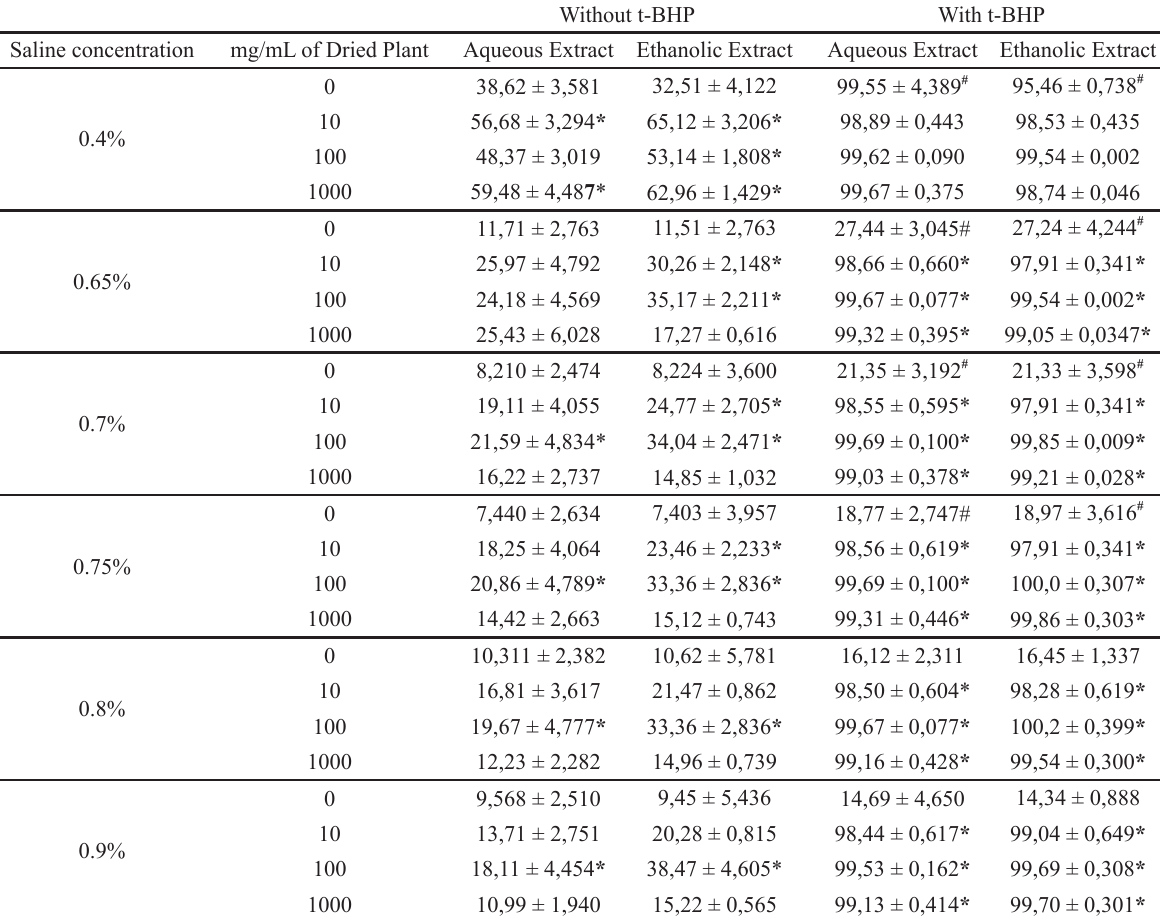
Effect of M. pulegium AE and EE on basal and/or t-BHP associated hemolysis. Without t-BHP With